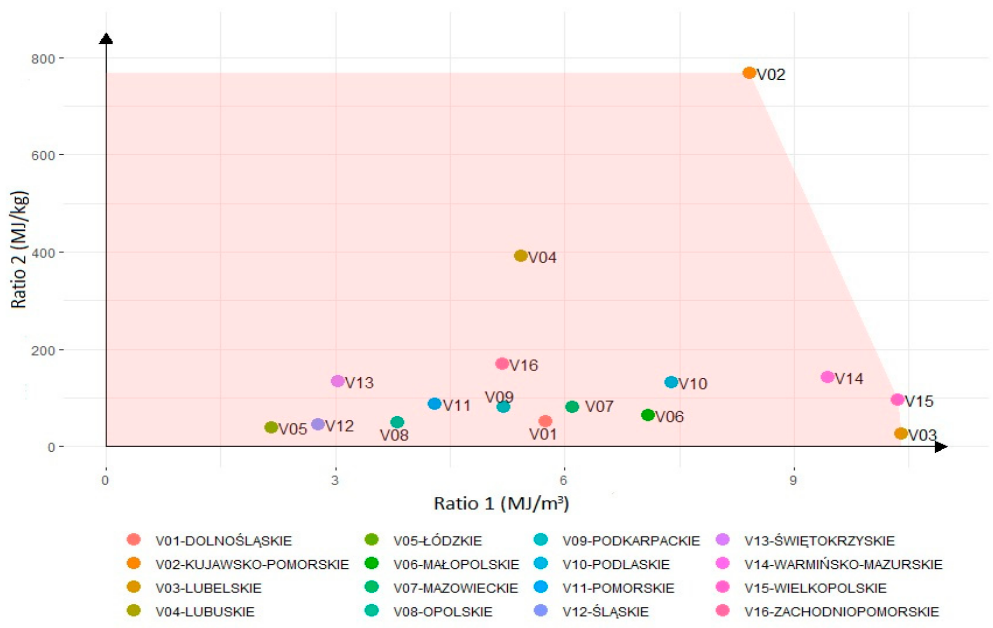
Figure 5. Efficiency of heat production from biogas and biomass in 2018 in Poland.